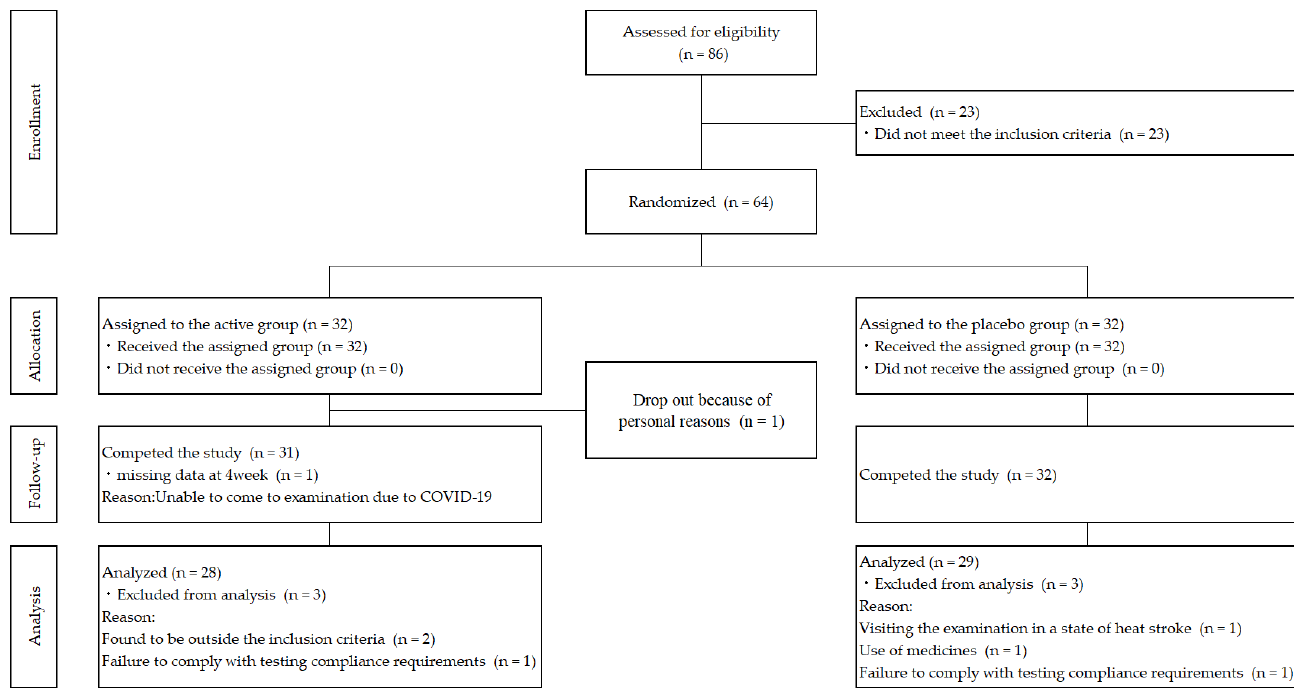
Figure 1. Flow diagram of the participants.